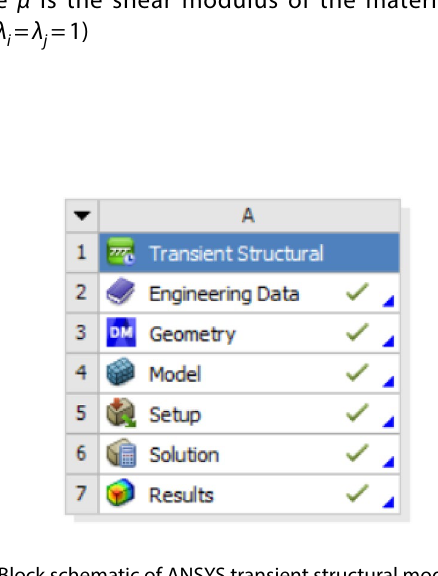
Fig. 4 Block schematic of ANSYS transient structural